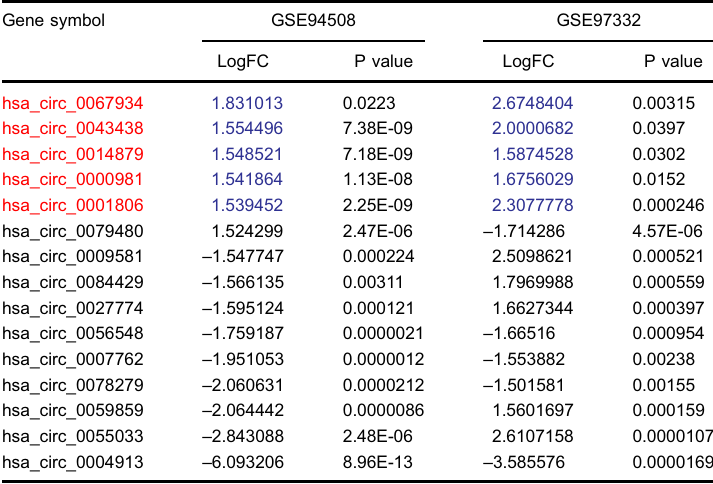
Table 2. The intersected circRNAs form differentially expressed circRNAs in 2 gene sets. Gene